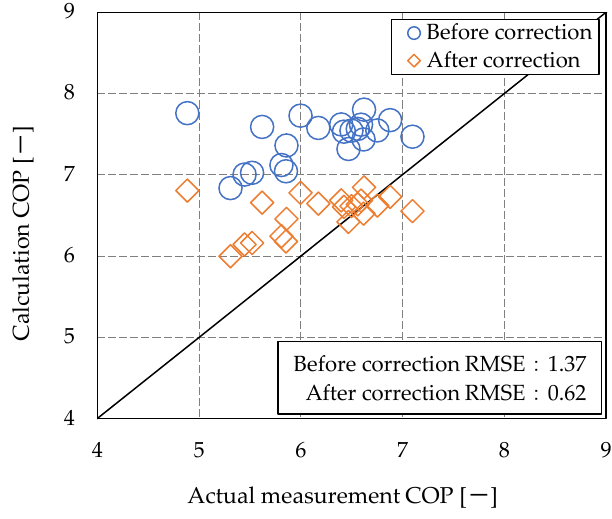
Figure 9. Accuracy verification results of heat pumps.